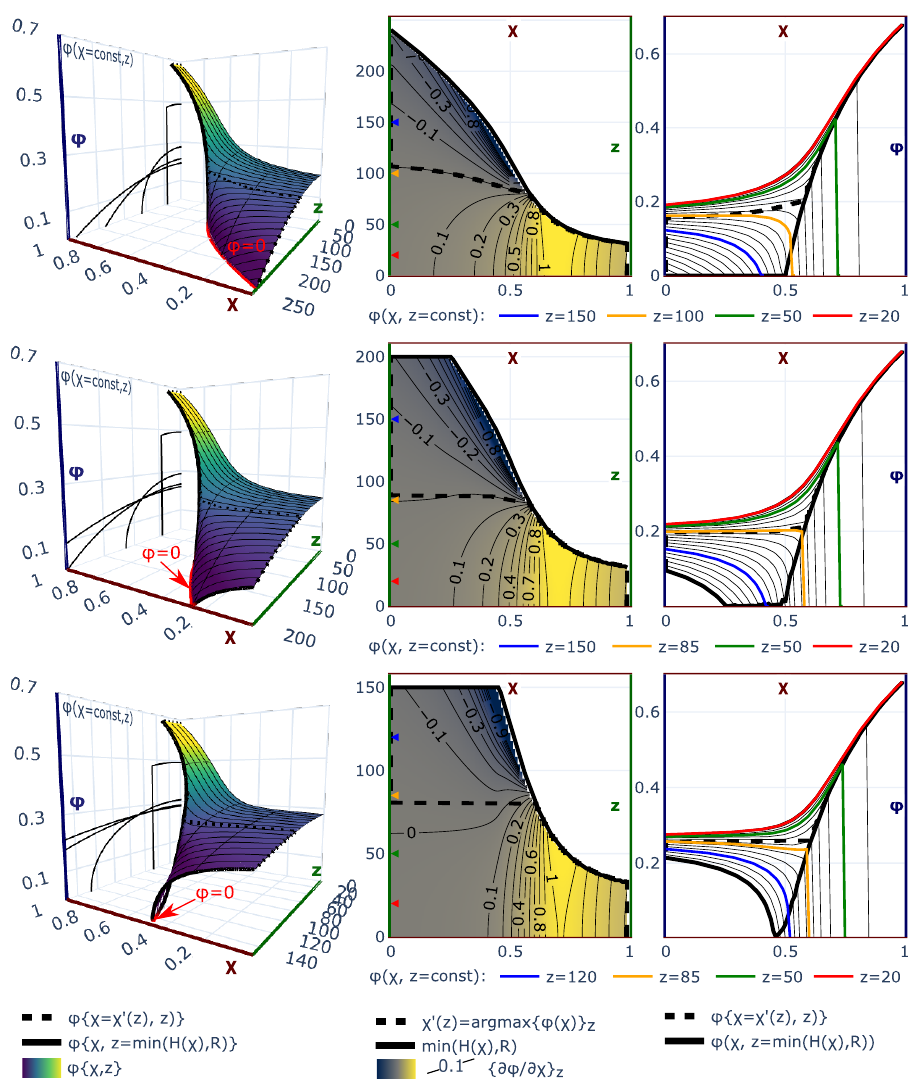
Figure 5. Polymer volume fraction φ ( χ , z ) (left column), contour plot of the derivative (cid:18) (cid:19) ∂φ ( χ , z ) / ∂χ in the ( χ , z ) plain (middle column) and dependence of the local polymer volume z fraction φ on χ at selected distances z from the pore wall (right column) for the brush of linear chains, N = 1000, σ = 0.02 grafted in cylindrical pore. The rows of the grid correspond to differ- ent pore radii: R = 250 (unconfined at any χ brush, H ≤ R , upper row), R = 200,150 (confined (pore-filling) under good solvent condition brushes, middle and lower rows). Solid black lines in the left and right columns represent the local polymer volume fraction at the edge of the brush φ ( χ , z = min { H ( χ ) , R ) } ) ; in the middle column, φ ( χ , z = min { H ( χ ) , R ) } ) is projected on χ − z plane, thus tracing the dependence of min { H ( χ ) , R ) } on χ . Dashed black lines in the middle column correspond to the values of χ for every given z that maximises the local polymer volume fraction χ (cid:48) = argmax { φ ( χ ) } z ; corresponding maxima in the polymer volume fraction φ ( χ (cid:48) ( z ) , z ) are plotted with dashed black lines in the left and right